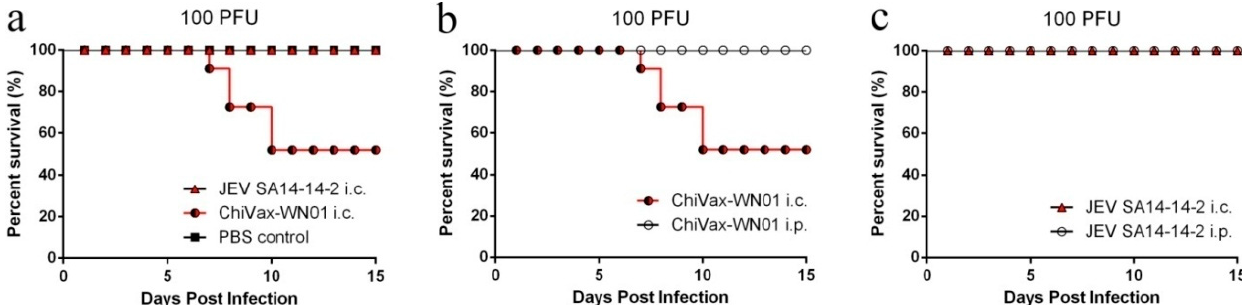
Figure 4. Virulence of viruses following intraperitoneal (i.p.) and intracranial (i.c.) inoculation. ( a ) Four-week-old BALB/c mice ( n = 10) were inoculated with 100 PFU of ChiVax-WN01 or JEV SA14-14-2 i.c. ( b ) BALB/c mice ( n = 10) were inoculated with 100 PFU of ChiVax-WN01 i.c. or i.p., respectively. ( c ) BALB/c mice ( n = 10) were inoculated with 100 PFU of JEV SA14-14-2 i.c. or i.p., respectively. The ChiVax-WN01 presented clear neurovirulence but no neuroinvasiveness for mice.